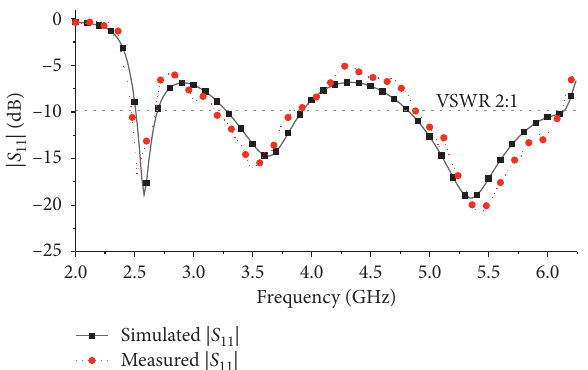
Figure 14: Simulated and measured | S